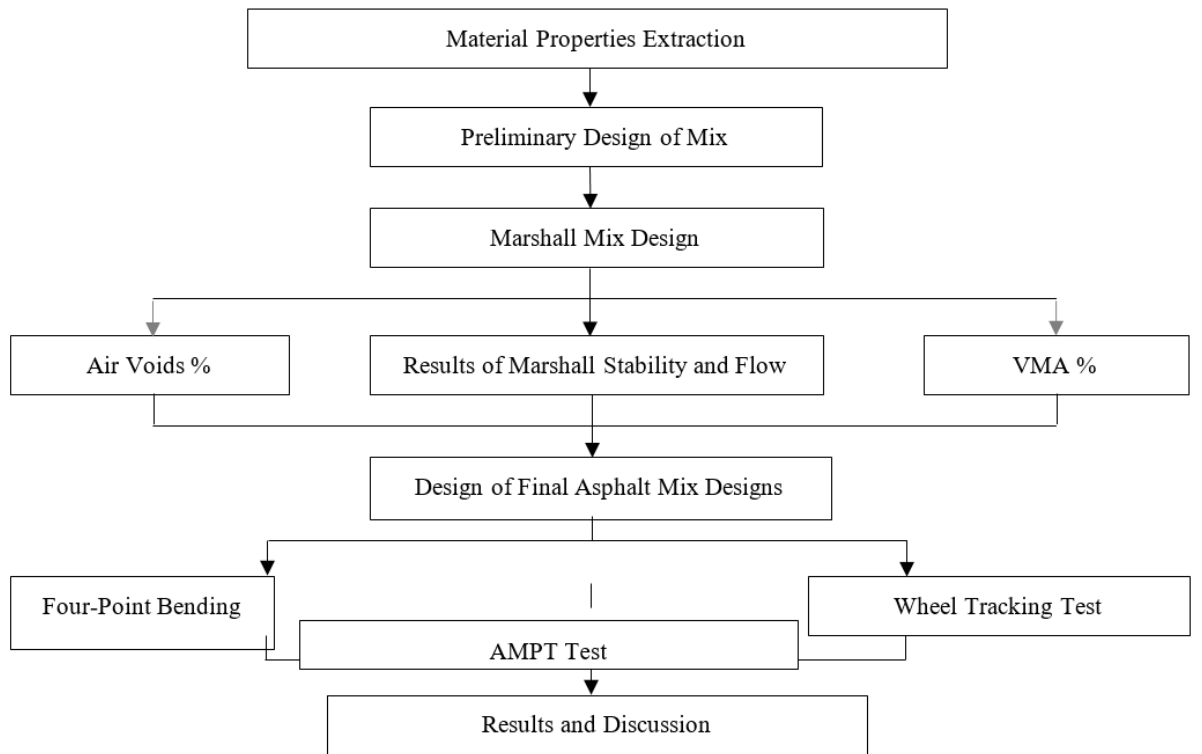
Figure 1. Outline of the research.